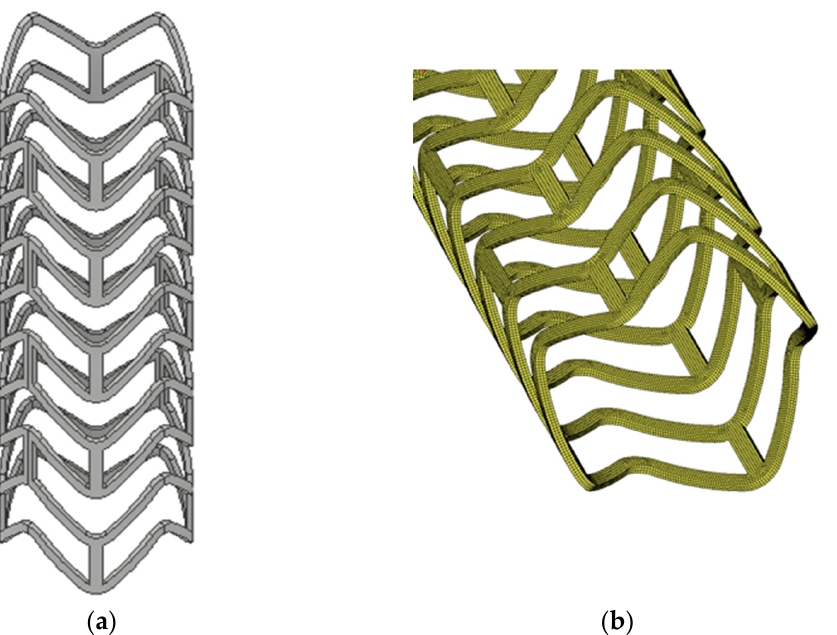
Figure 9. The modified stent model after deployment simulation selected for the crimping process: ( a ) geometry, ( b ) discretized using finite elements.